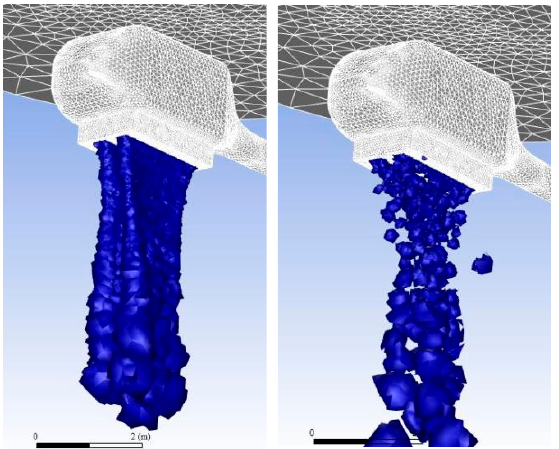
Figure 18. Local panorama of contour surface when the volume fraction of the water–air phase below the helicopter belly was 0.01 (( left ), t = 0.9 s; ( right ), t = 1.9